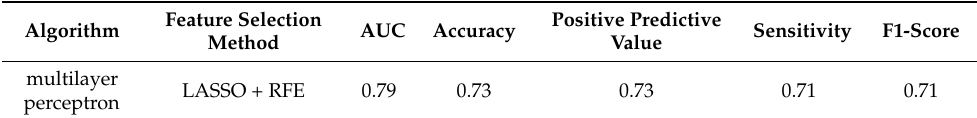
Table 4. Performance metrics of multilayer perceptron model.